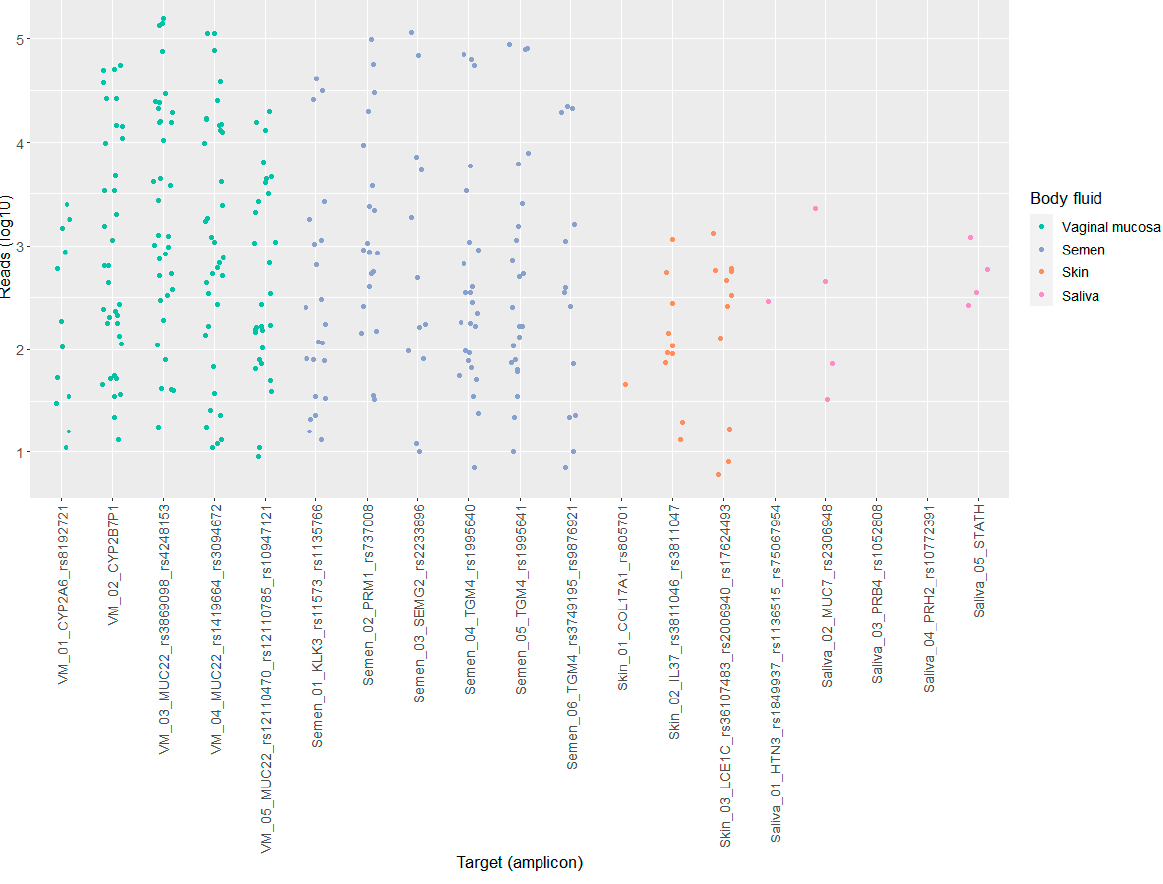
Figure 2. Scatter plot displaying the distribution of reads (log10) per targets (amplicon) for saliva, semen, skin and vaginal mucosa (VM), n = 36.